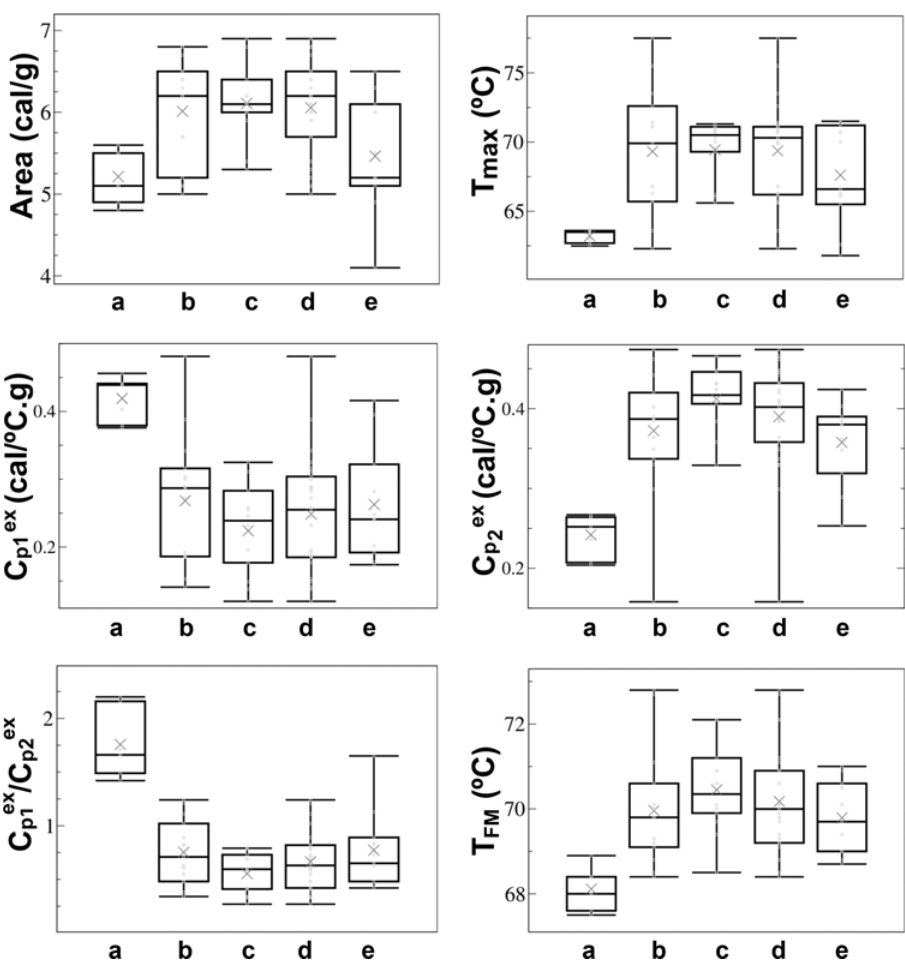
Fig 5. Box chart representations of thermogram feature parameters. For each panel, boxes from left to right represent serum samples from (a) healthy controls, (b) MGUS- κ , (c) MGUS- λ , (d) All-MGUS (which compiles MGUS- κ and MGUS- λ samples together) and (e) non-MGUS. The bottom and top box edges indicate the 25 th and 75 th percentiles. Within the box, the median value is indicated by the horizontal line, and the mean by the cross inside the box. The whiskers extend from the ends of the boxes to the minimum and maximum experimental